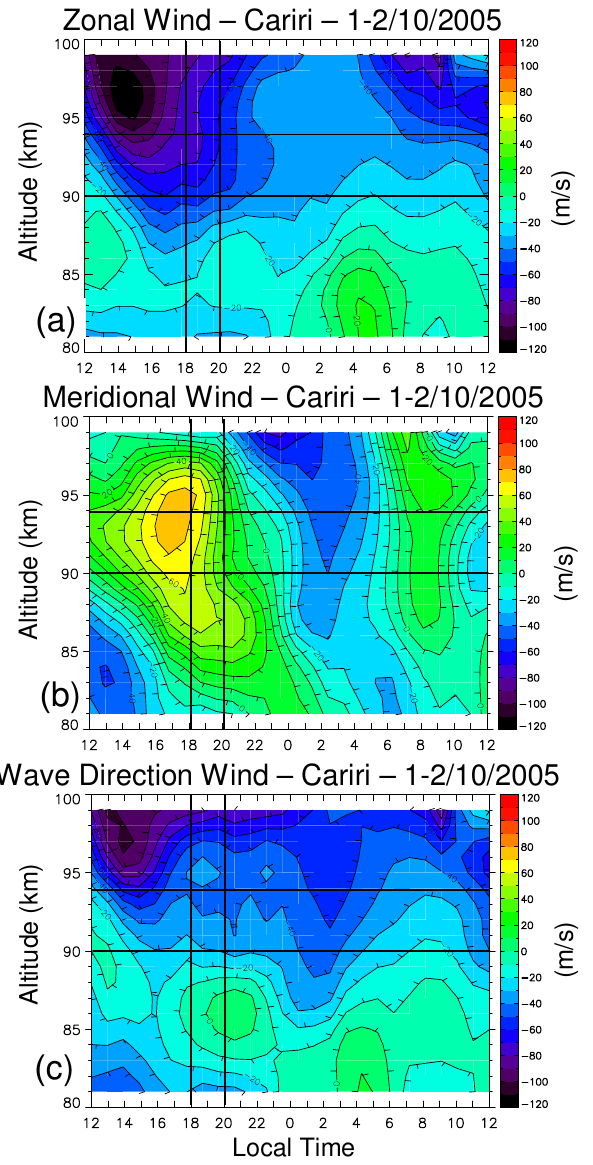
Fig. 4. Contour plot of (a) zonal wind, (b) meridional wind and (c) wind in the direction of wave propagation measured with meteor radar between 12:00(LT) of 1 October 2005, and 12:00(LT) of 2 October 2005, over S˜ao Jo˜ao do Cariri, PB, Brazil. The vertical solid lines indicate the observation time of the wave front and the horizontal solid lines delimit the top and bottom of the duct showed in the Fig. 2.